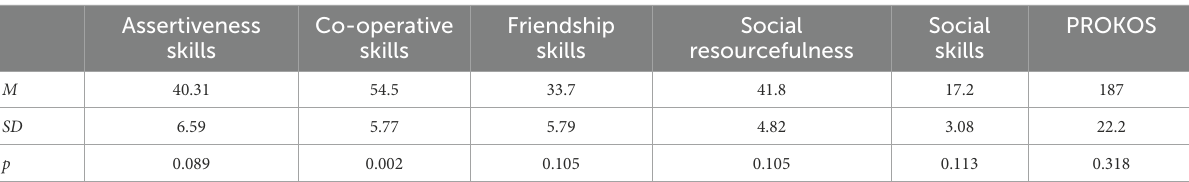
TABLE 6 Normality of distribution of the PROKOS ( N =